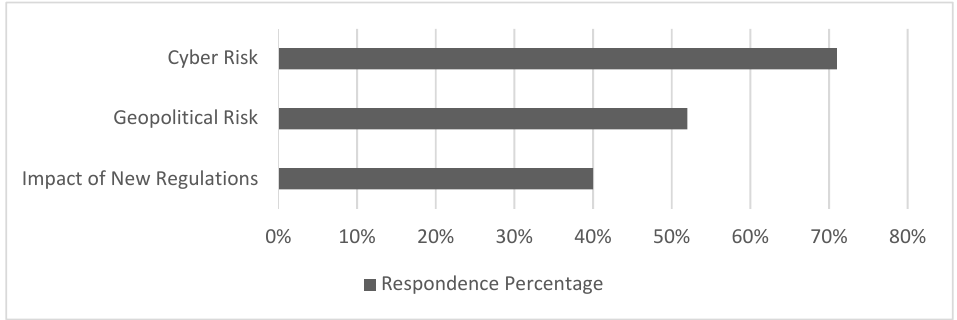
Figure 2. Banking risk threat survey by DTCC 2017 Quarter 1 (Souce: DTCC 2017).